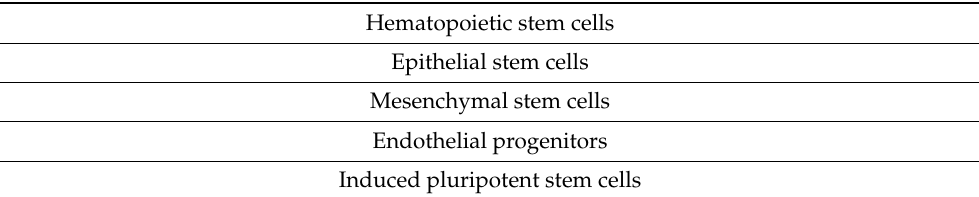
Table 1. Various cells extracted from